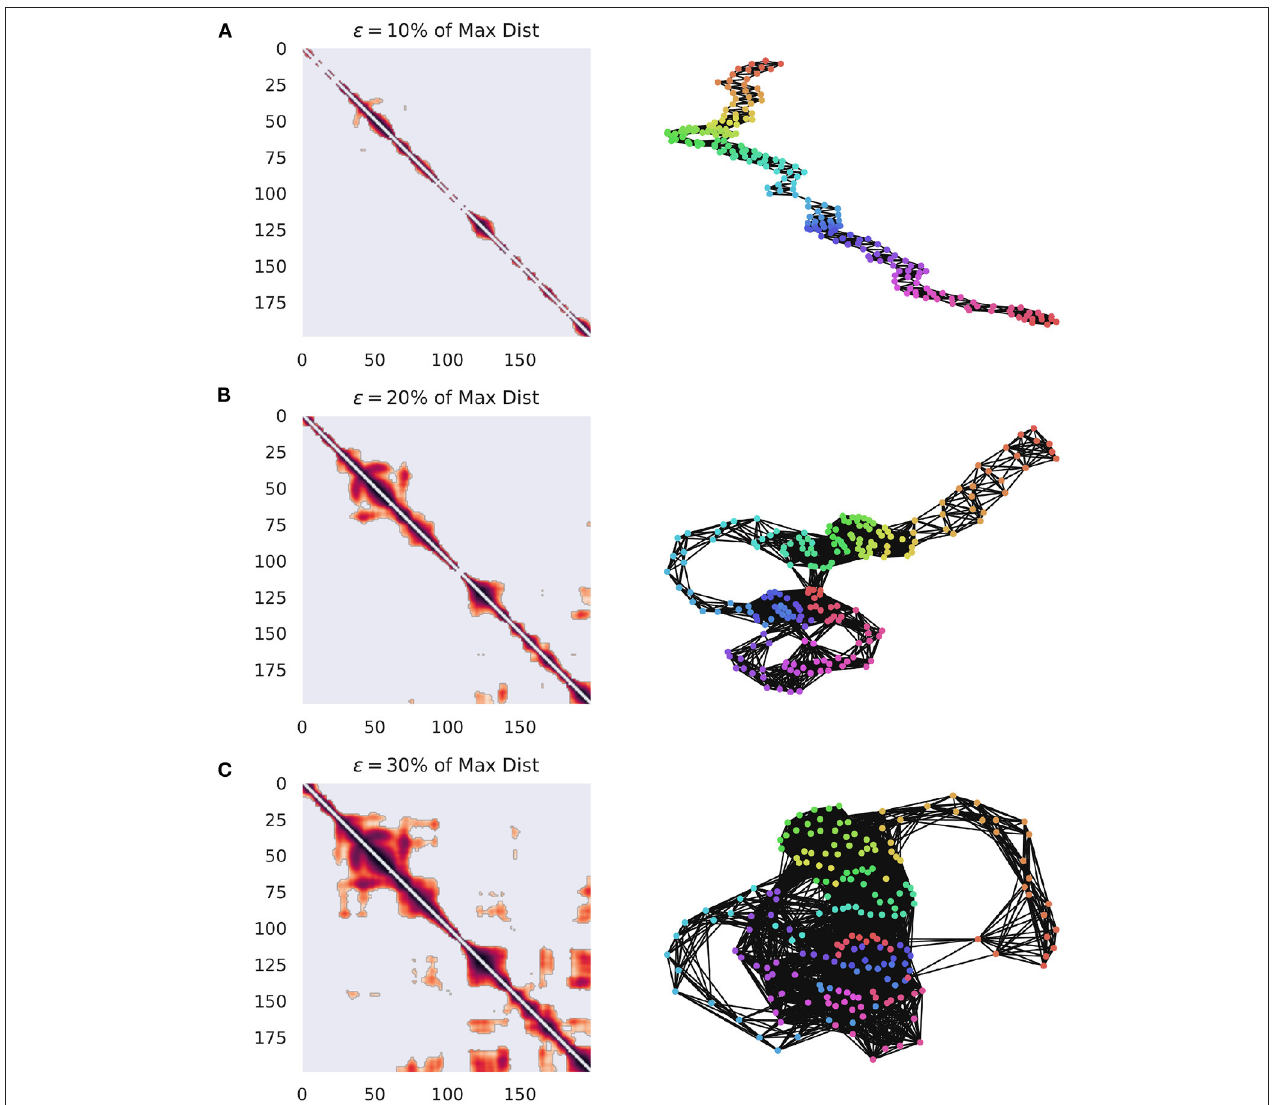
FIGURE 1 | Visualization of how G R changes when the value of ǫ is varied. The networks are constructed from ECoG data from the Neurotycho database and the distance function is the cosine distance (Nagasaka et al., 2011). (A) The weighted adjacency matrix and the associated RN thresholded at 10% of the maximal distance in the point cloud. It is clear that this is too low of a threshold, since every point is only similar to it’s immediate past and future, creating a path graph. (B) The same network, this time thresholded at 20% of the maximum distance. Note that clear cyclic structures, indicating recurrences have started to appear, suggesting that the system is returning to particular regions of phase-space at distinct points in time. (C) The same network, this time thresholded at 30% of the maximum distance. This one captures even more meaningful recurrences, although at the cost of a much denser network.